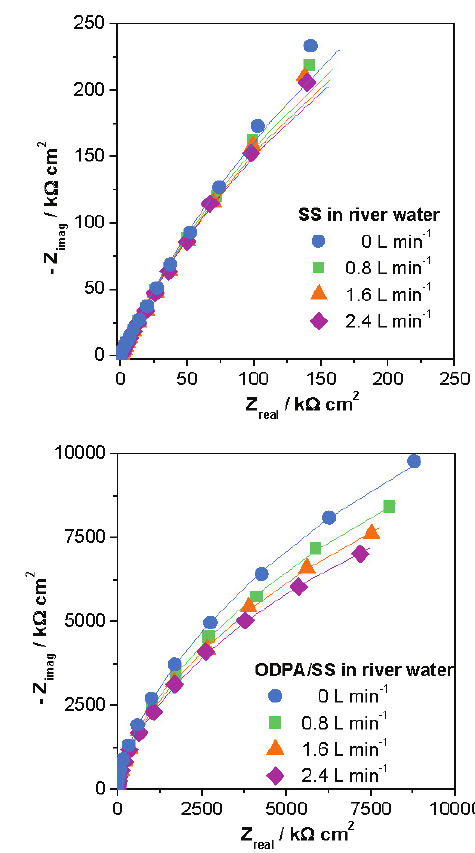
Fig. 8 – Nyquist plots of EIS spectra for blank and ODPA-treated stainless steel in different river water flow rates. Dots represent experimental data, and lines represent the fitted data obtained by fitting the spectra to models given in Fig.